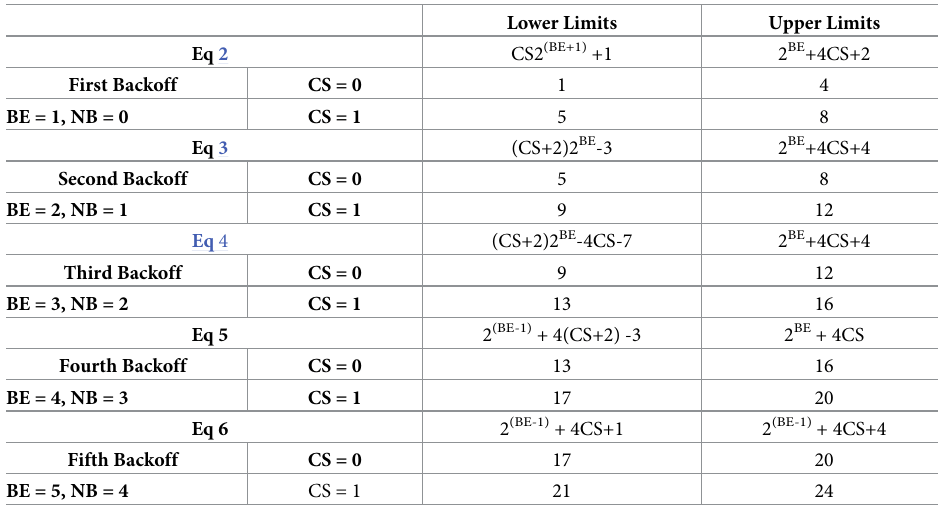
Table 3. CSTP-MAC algorithm mathematical